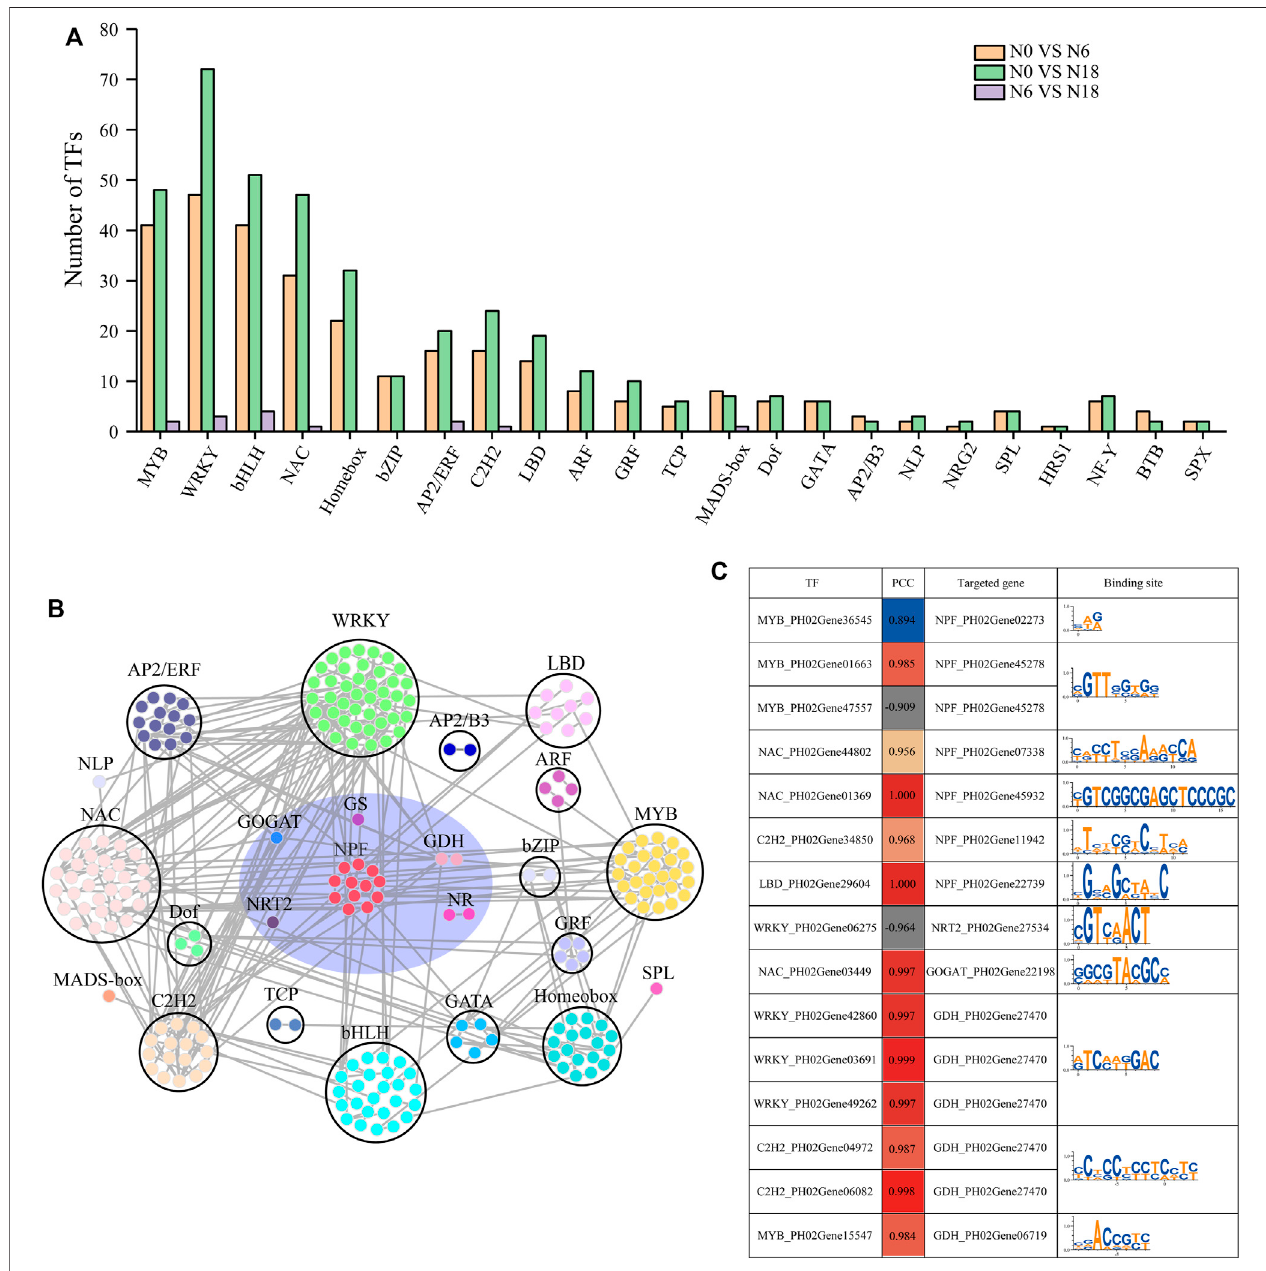
FIGURE4 | TFs identi fi ed from DEGs and their targeted genesinvolved in nitrogen metabolism: (A) statistics ofTFs; (B) coexpression networkof TFs and nitrogen metabolism genes based on WGCNA and BambooNET; (C) PCC of TFs and their targeted genes involved in nitrogen metabolism. miRNA sequencing uncovered the DEMs in roots under different nitrogen